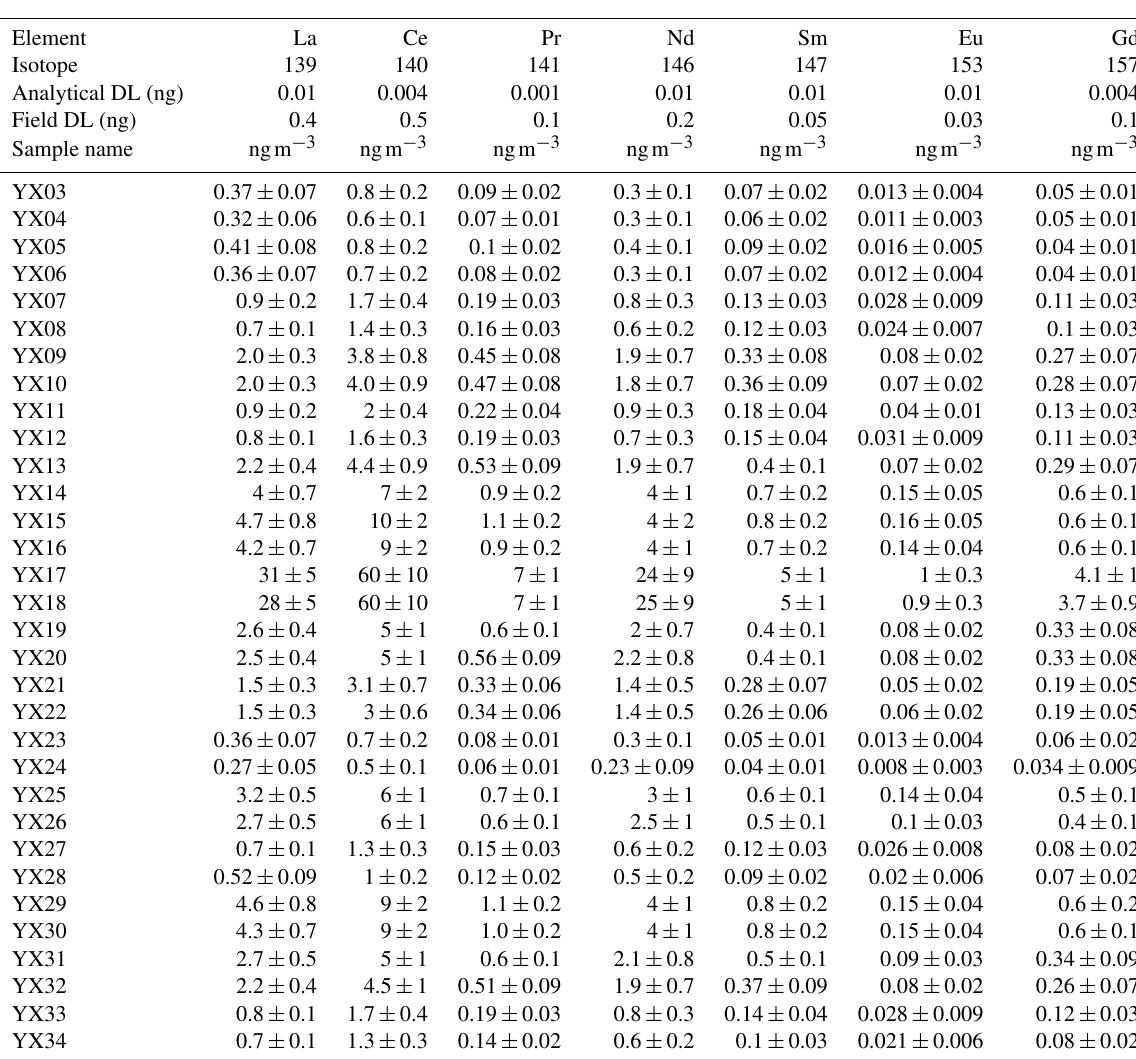
Table A6. REE air concentrations measured with